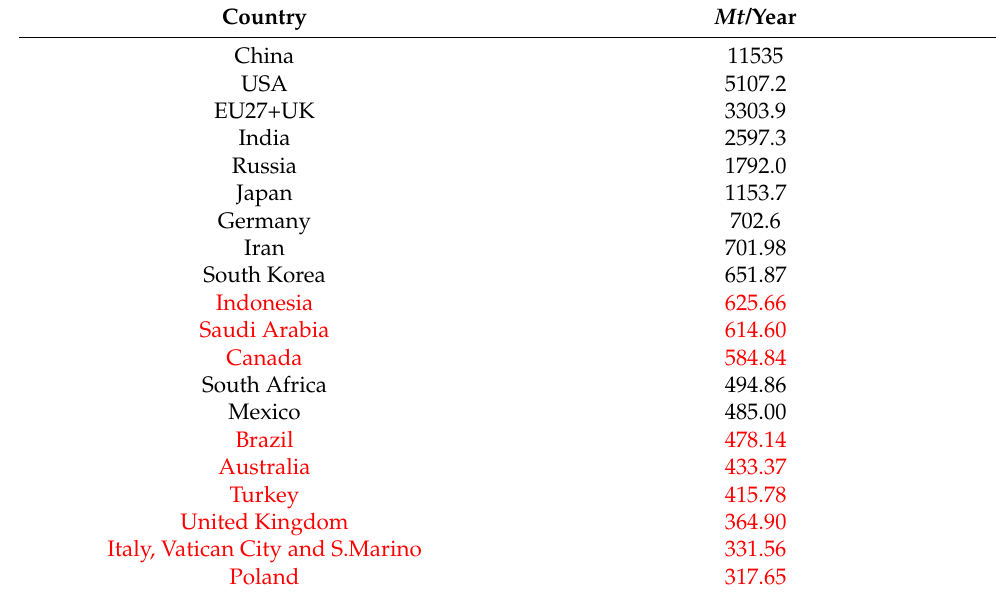
Table 10. Twenty top emitters countries and differences with the CE 2 N classification. Own